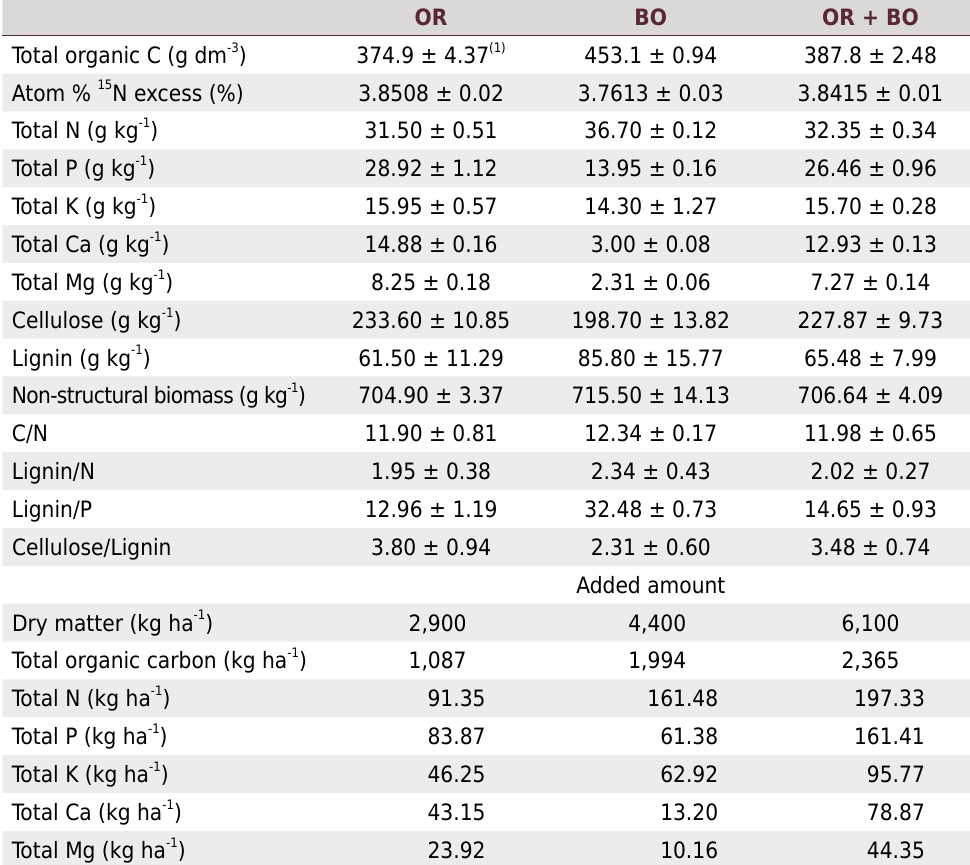
Table 1. Chemical composition of oilseed radish (OR), black oat (BO), and oilseed radish + black oat (OR + BO) residues OR BO OR + BO Total organic C (g dm -3